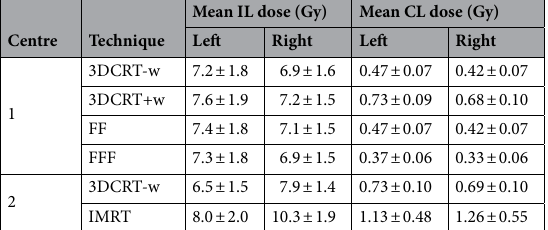
Mean IL dose (Gy) Mean CL dose (Gy) Centre Technique Left Right